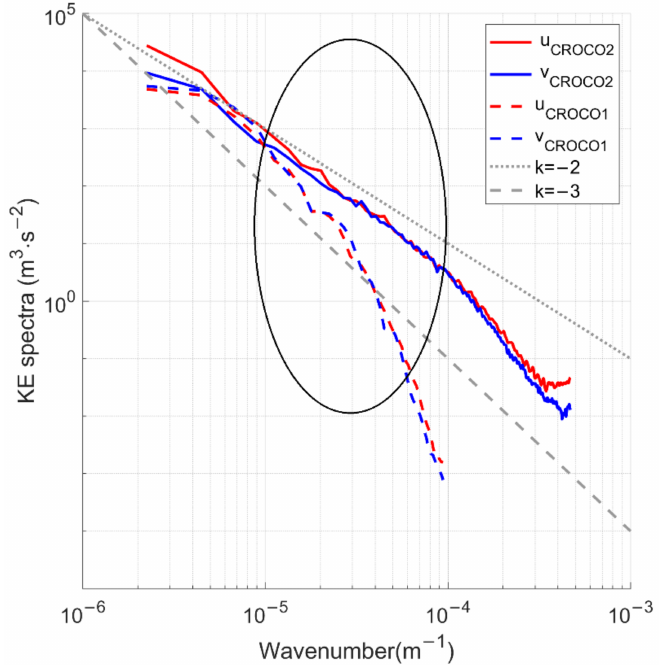
Figure 4. Kinetic energy power spectra of zonal velocity ( u ) and meridional velocity ( v ) at 2 m depth in CROCO1 (dashed lines) and CROCO2 (solid lines). The ellipse highlights the range of wavenumber from 10 − 5 to 10 − 4